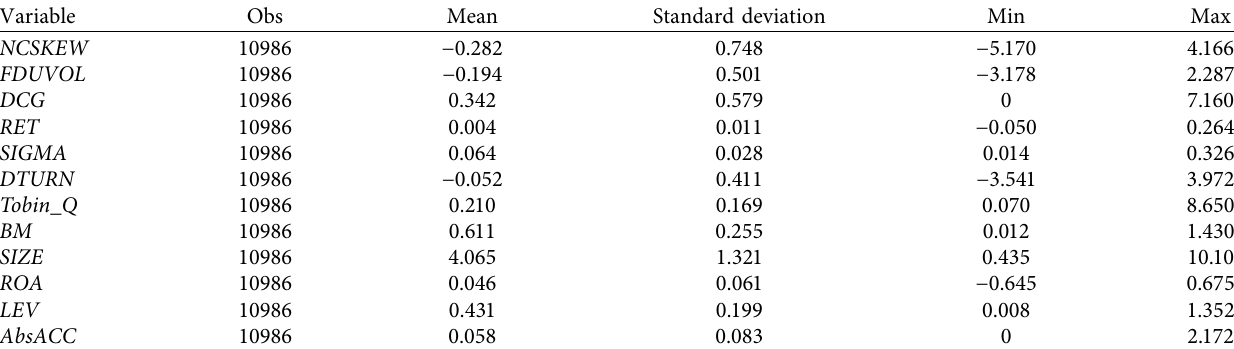
Table 1: Variable